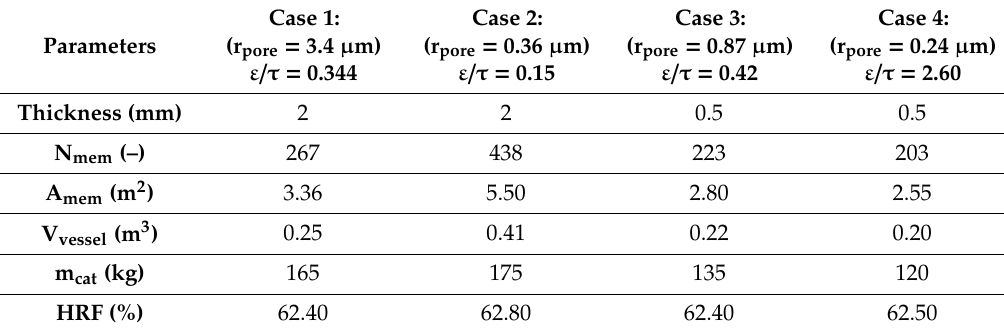
Table 7. New reactor dimensioning compared to